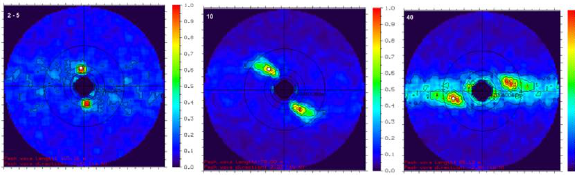
Figure 10. Example for three situations of TerraSAR-X acquisitions for similar sea state traveling in different directions (peak wavelength ~80m-100m): azimuth traveling (left), range traveling (right) and intermediate situation. The azimuth traveling waves are minimally distorted by non-linear effects, the shape of image spectra approaches shape of wave spectra; for 45° traveling waves the distortions are already visible, and for range traveling waves, the distortions dominate.